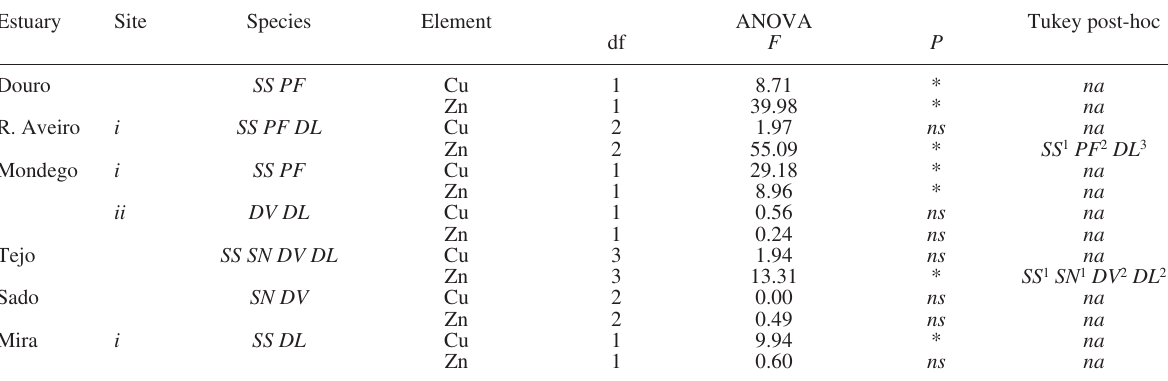
Table 5. – Inter-specific variation in trace metal concentration in muscle of juveniles within each estuarine site. Results of ANOVA compari- sons and Tukey post-hoc multiple comparison tests for Cu and Zn concentrations in muscle of juveniles of five fish species ( SS , Solea solea ; SN , Solea senegalensis ; PF , Platichthys flesus ; DV , Diplodus vulgaris; and DL , Dicentrarchus labrax ) collected at the same site within eight estuaries along the Portuguese coast (Douro, Ria de Aveiro, Mondego, Tejo, Sado, Mira, Ria Formosa and Guadiana). * P <0.05; ns , non- significant; different numbers (superscript) represent significant differences among species at P <0.05 in Tukey post-hoc tests; na , post-hoc tests not applicable.